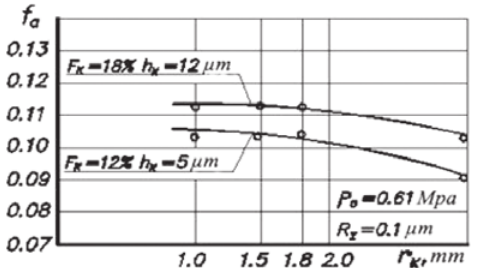
Fig. 9. Dependence of the adhesion component of the friction factor f а on the roughness R Z of the sample carrying surface